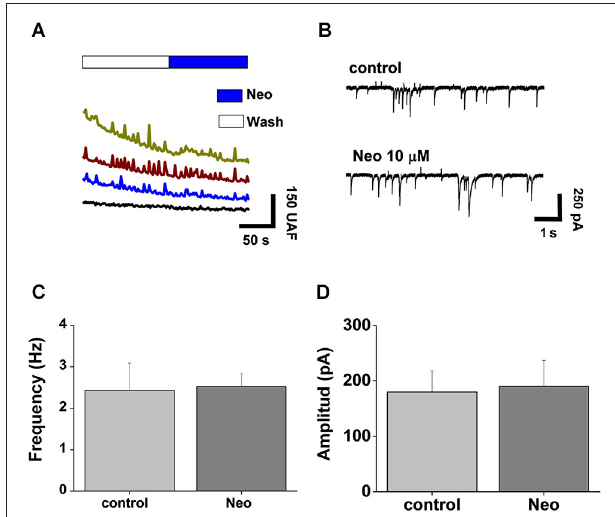
FIGURE 2 | Acute application of Neocuproine does not alter synaptic transmission . (A) Calcium transients of hippocampal neurons in the absence or presence of Neocuproine (Neo, 10 µ M). (B) Typical miniature synaptic currents obtained in the absence or presence of Neocuproine (Neo, 10 µ M). The graphs summarize the frequency (C) and the amplitude (D) values of miniature synaptic currents recorded in three independent experiments performed under the conditions described in “ (B) ”. In both cases values are mean ± SEM ( N = 3).